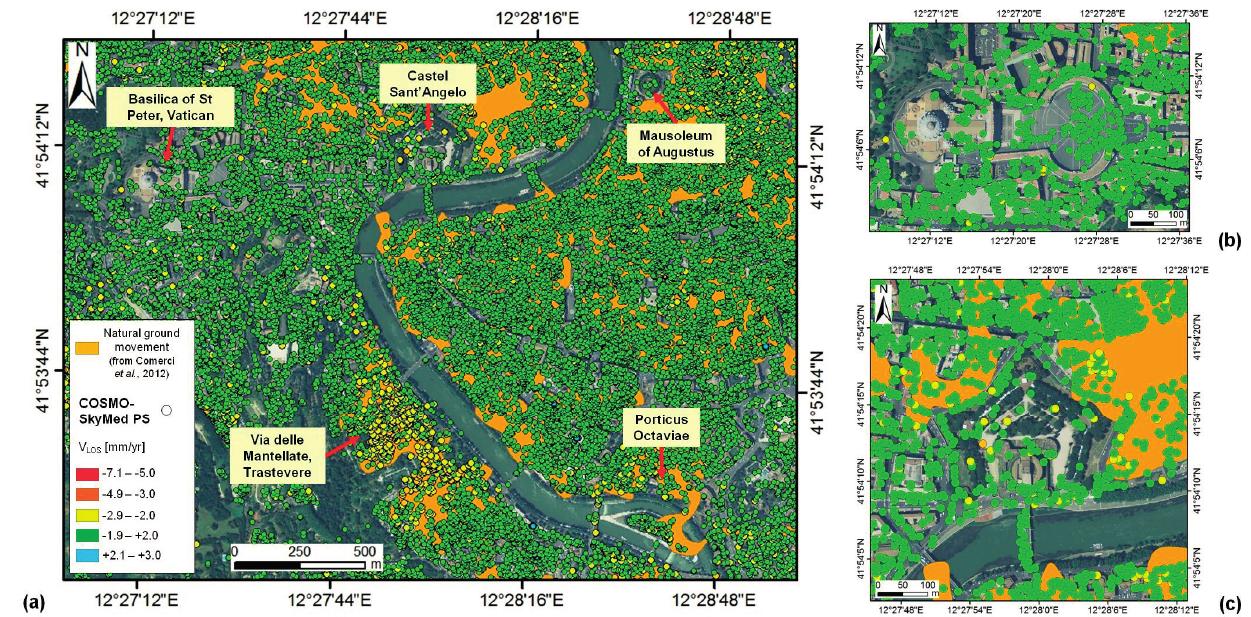
( b ) Basilica of St. Peter and ( c ) Castel